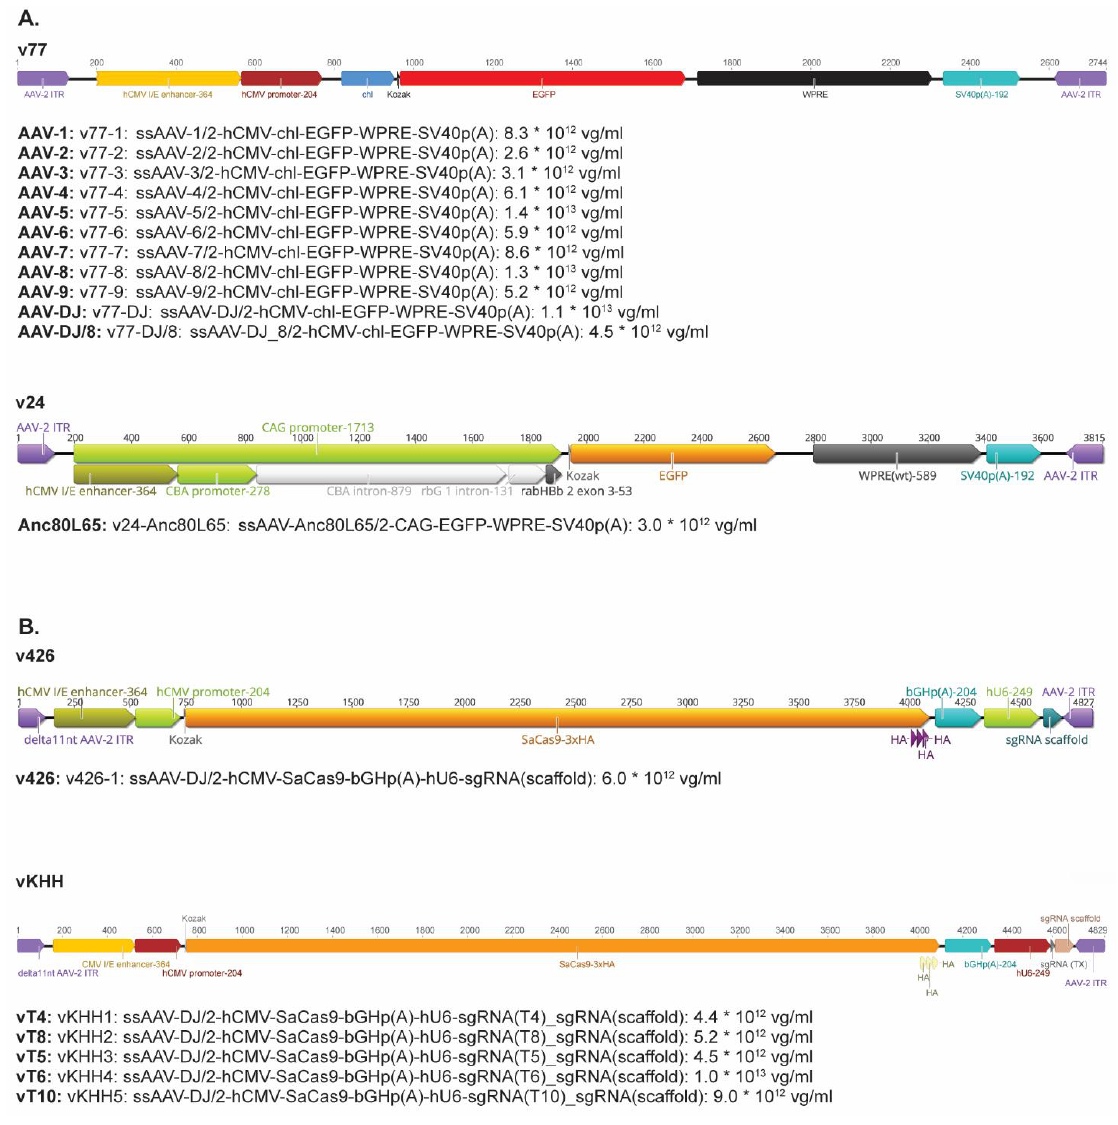
Figure A1. Schematic representation and concentration of the AAV vectors used in this study. ( A ). AAV vectors used for the determination of the tropism. ( B ). Gene therapy vectors.